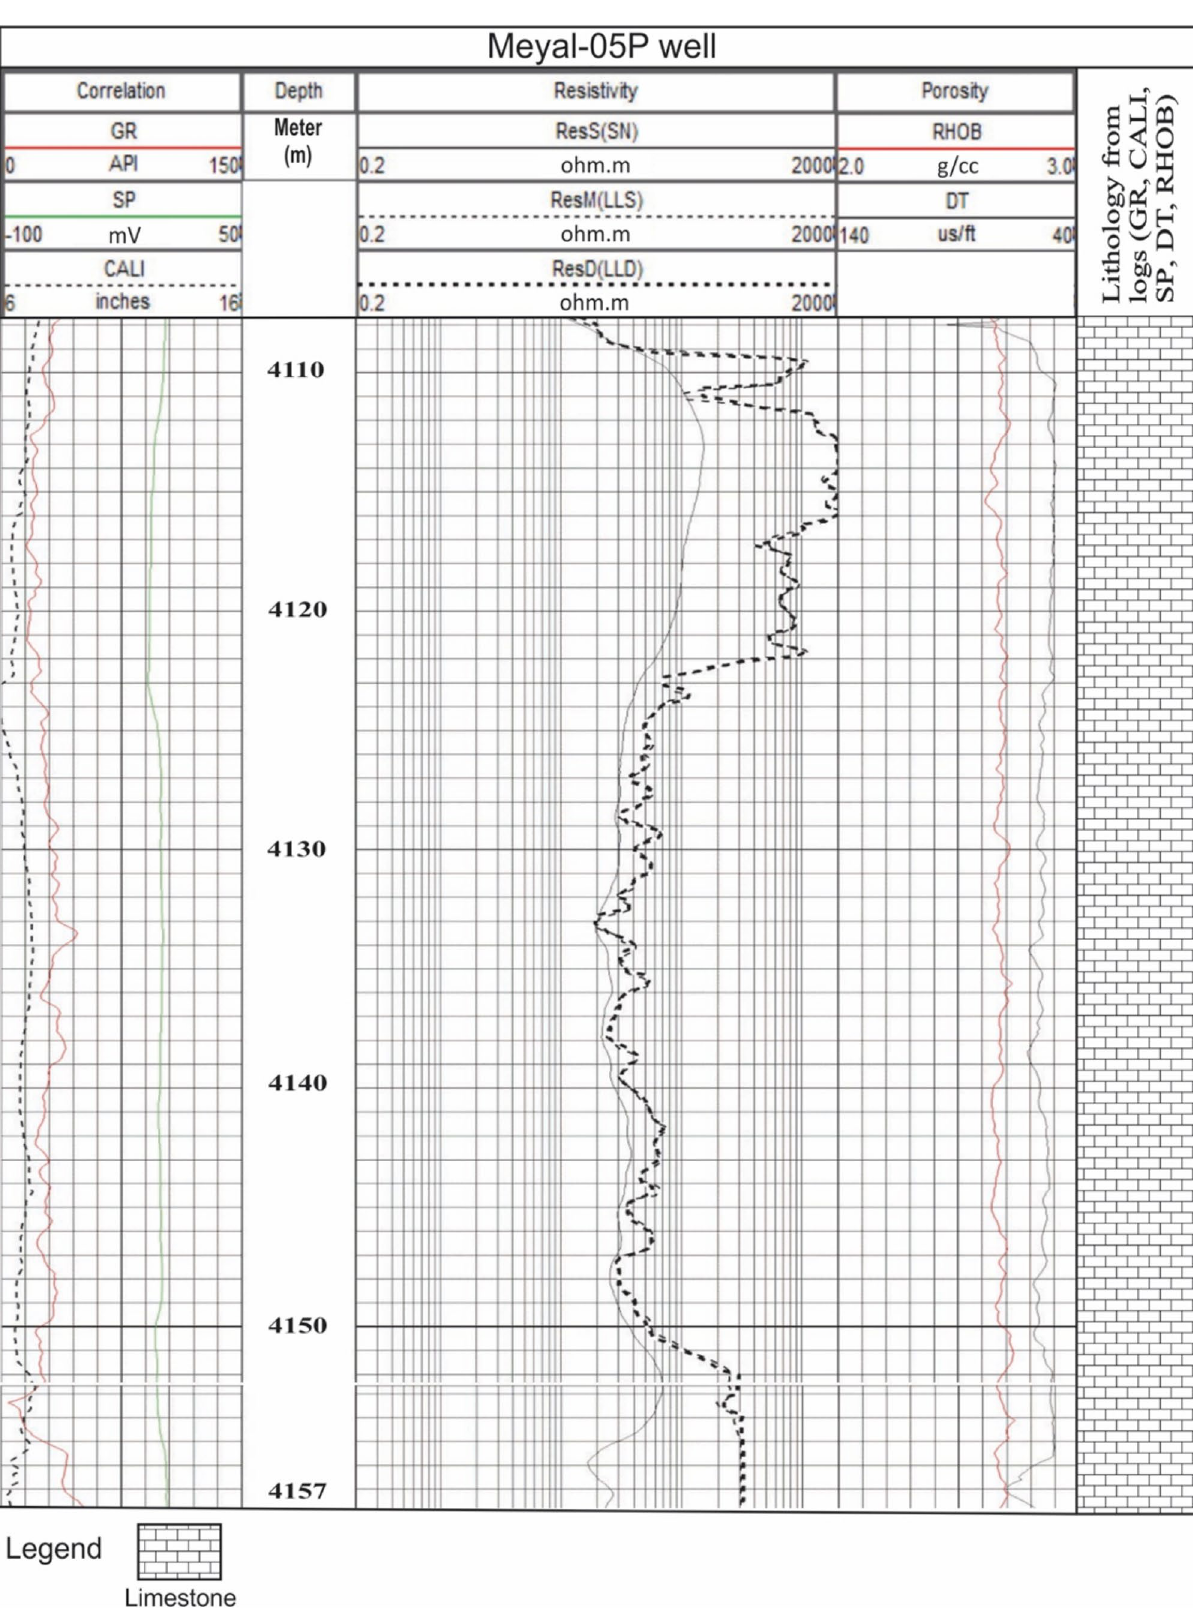
Fig. 16 Lithology interpretation of the Lockhart Limestone of Meyal-05P from petrophysical